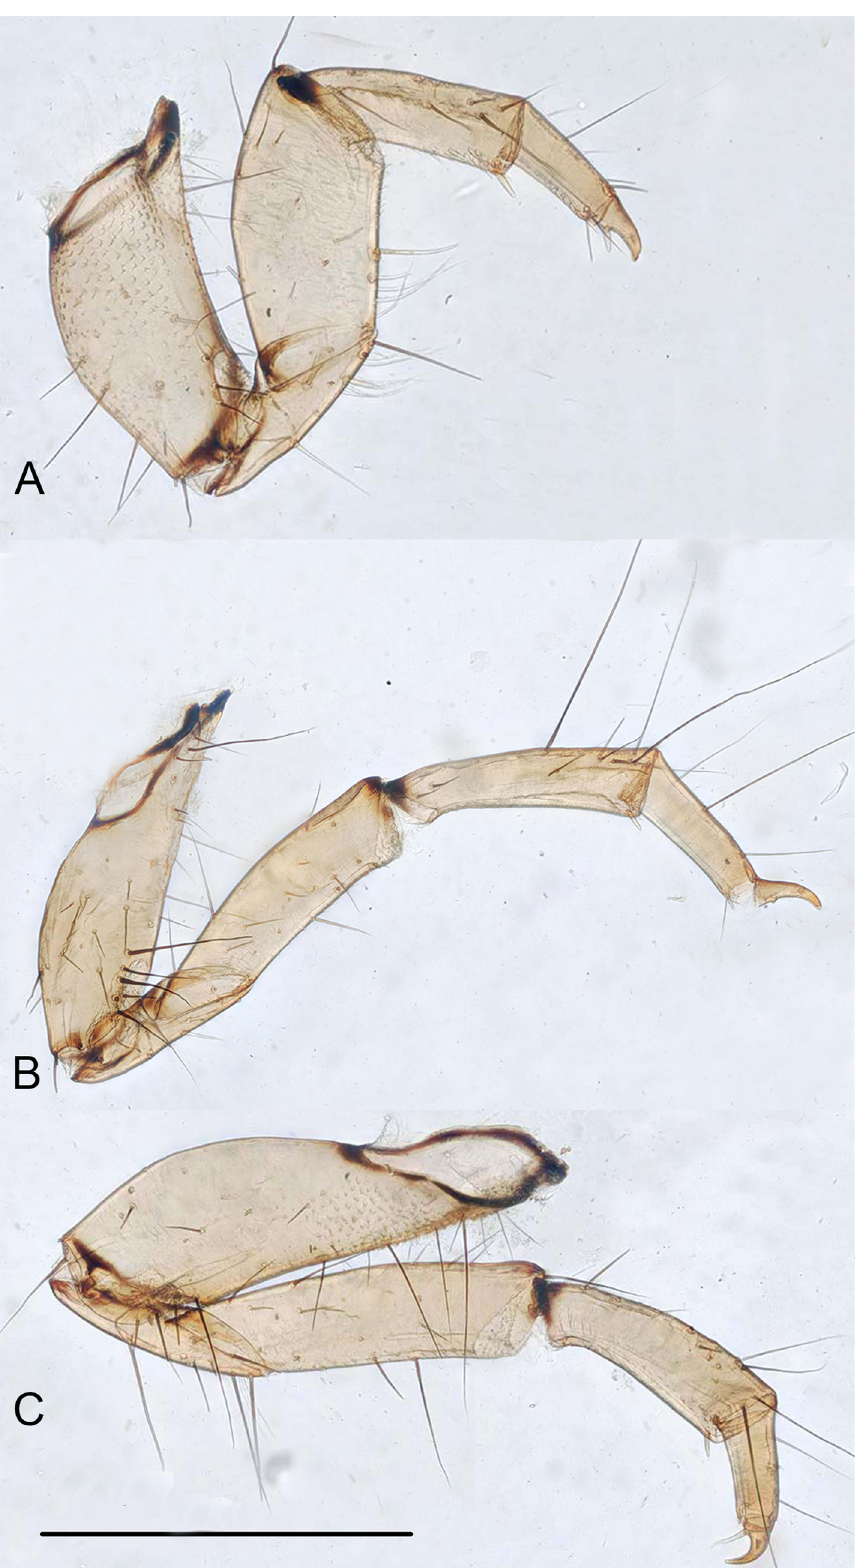
Fig. 11. Legs of Apatidelia acuminata Leng & Yang, 1998, larva. A . Foreleg (posterior face). B . Mid- leg (posterior face). C . Hind leg (posterior face). Scale bar = 0.5